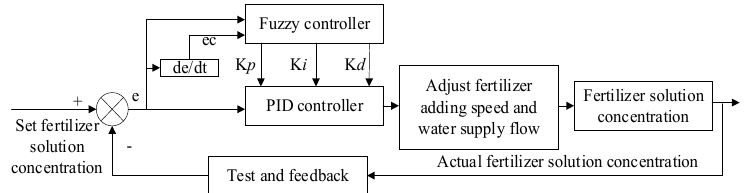
Figure 5. Fuzzy PID control system program diagram.